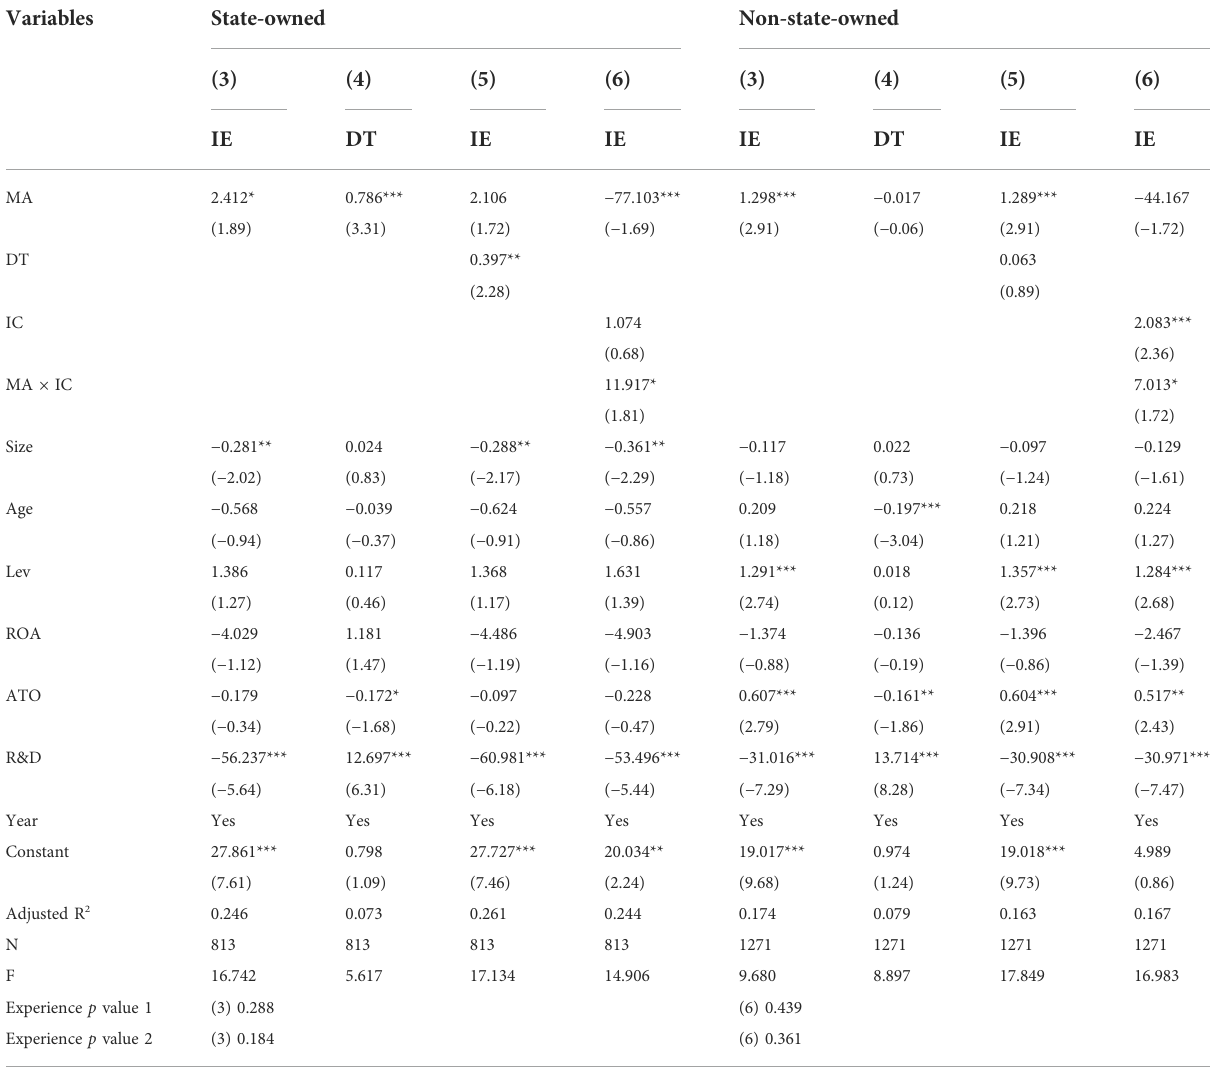
TABLE 4 Heterogeneity of property